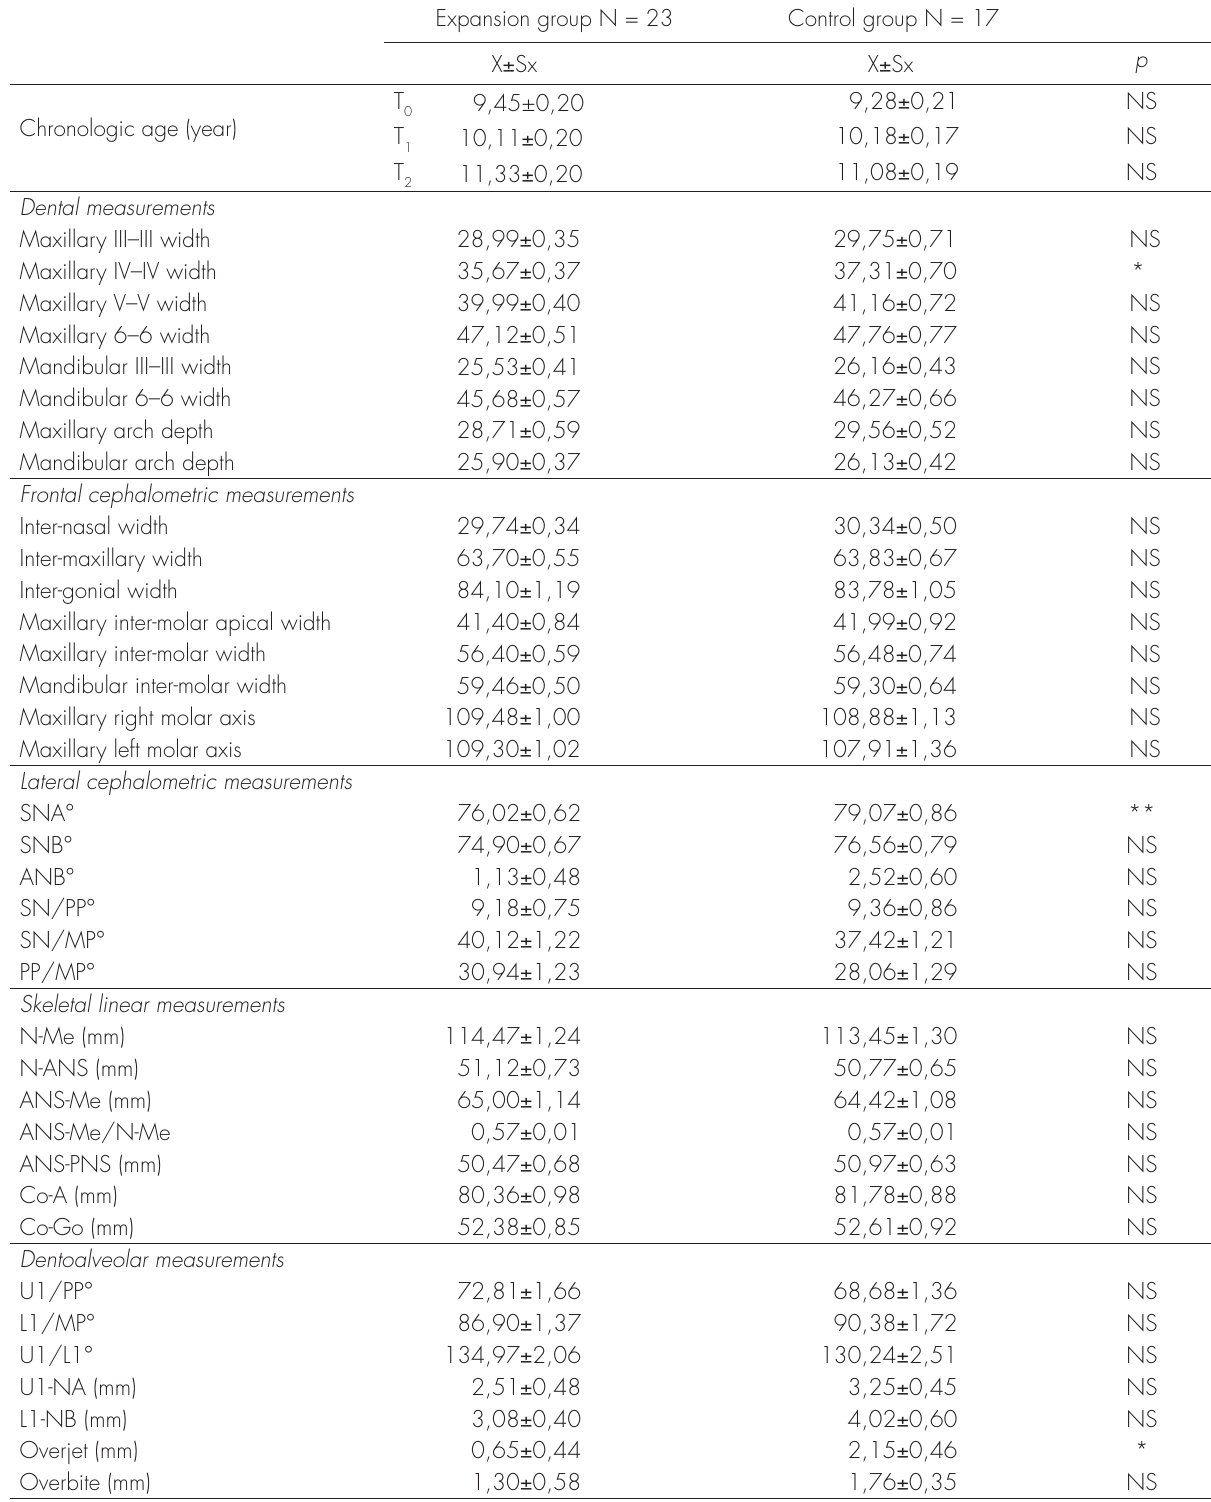
Table I. Comparison of pretreatment dental cast and frontal and lateral radiographic parameter values between the expansion and control